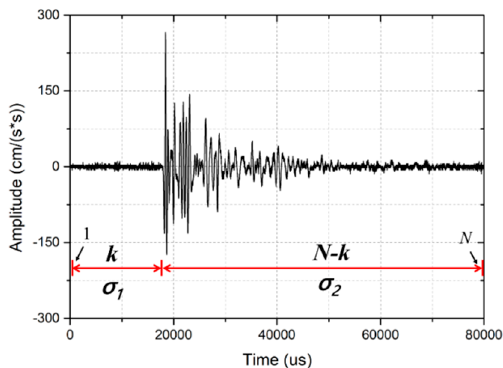
Figure 6. A time series of a wave signal is divided into two parts, the first part includes k samples and its normal distribution is σ 1 ; the second part includes (N– k) samples and its normal distribution is σ 2 .